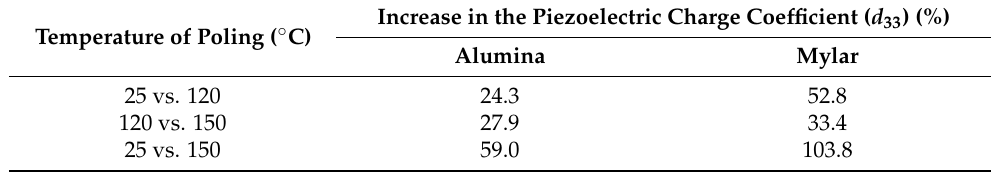
Table 1. Rate of increase in the piezoelectric charge coefficient ( d 33 ) according to the poling temperatures.